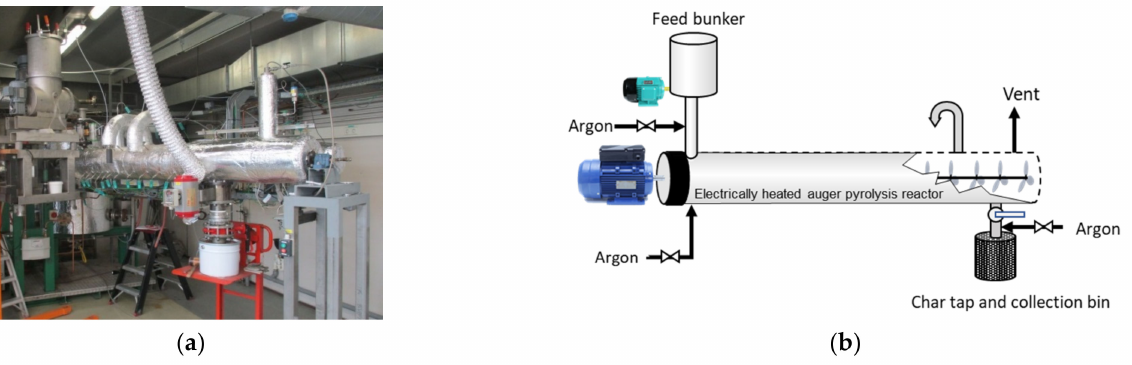
Figure 1. ( a ) Full view of the auger-fed pyrolysis reactor and ( b ) schema of the counter-current flow.